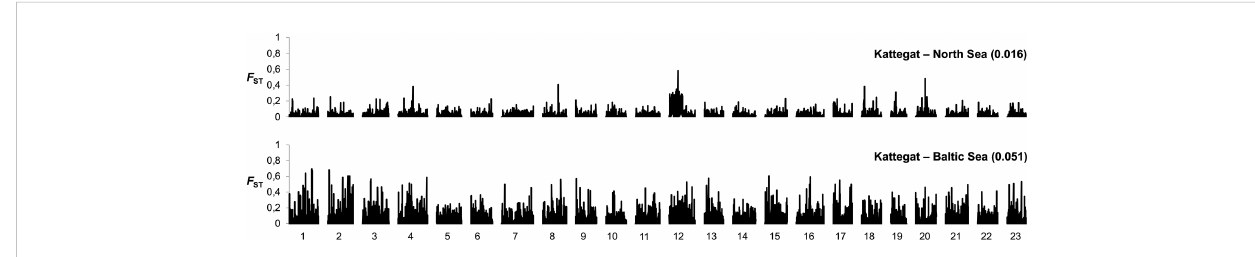
FIGURE 5 Genome-wide differentiation ( F ST ) in cod based on 8,309 SNPs across all 23 chromosomes in comparisons of cod from Kattegat and North Sea (top) and cod from eastern Baltic Sea and Kattegat (bottom). Median F ST estimates in the two pairwise comparisons are denoted in parentheses. Adapted from Berg et al., 2015, Figure